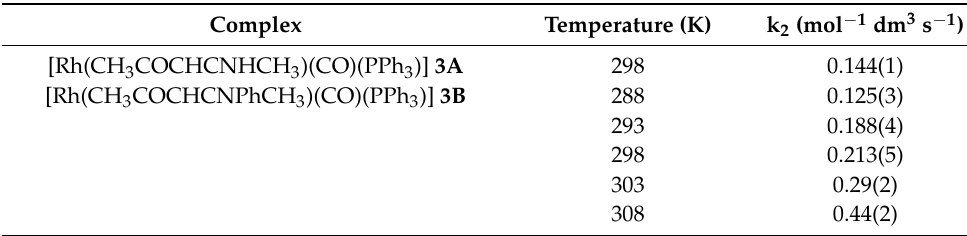
Table 4. Second-order reaction rate constants at different temperatures of the oxidative addition reaction between the [Rh(N,O-BID)(CO)(PPh 3 )] complexes and CH 3 I, as obtained from a UV–Vis kinetic